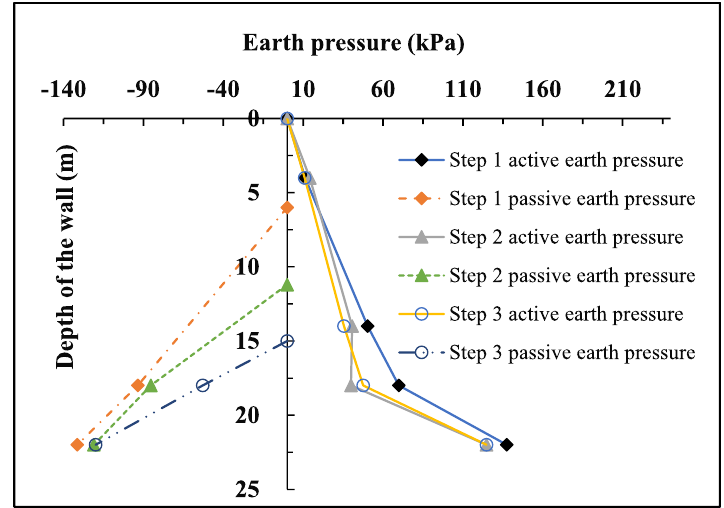
Figure 13. Earth pressure distribution of wall No. 2 from Step 1 to Step 3.